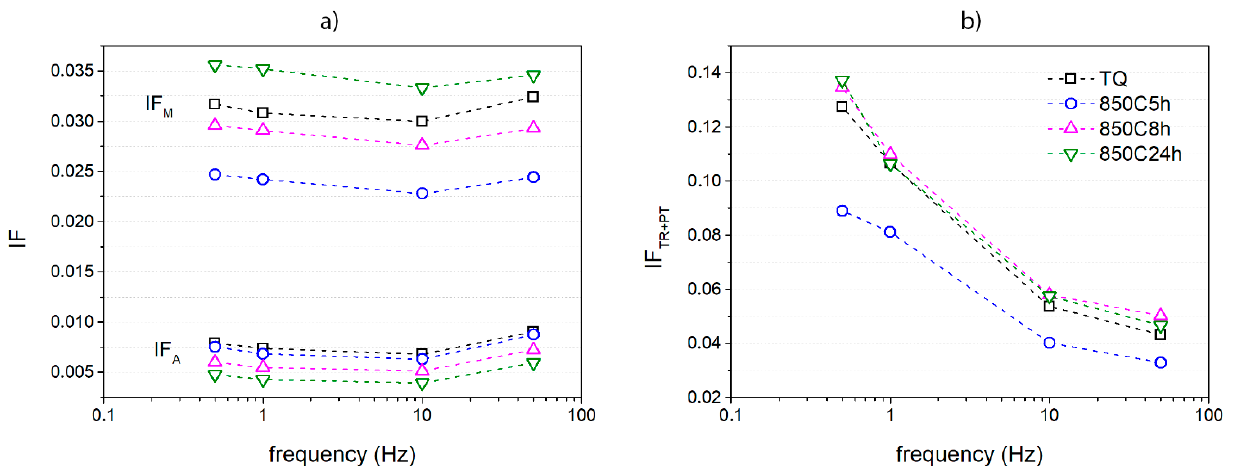
Figure 5. Summary of IF contributions vs. frequency for each NiTiCu20 sample in the cooling stage: ( a ) intrinsic IF values for austenite and martensite and ( b ) peak values due to the transient term and the phase transformation contribution.